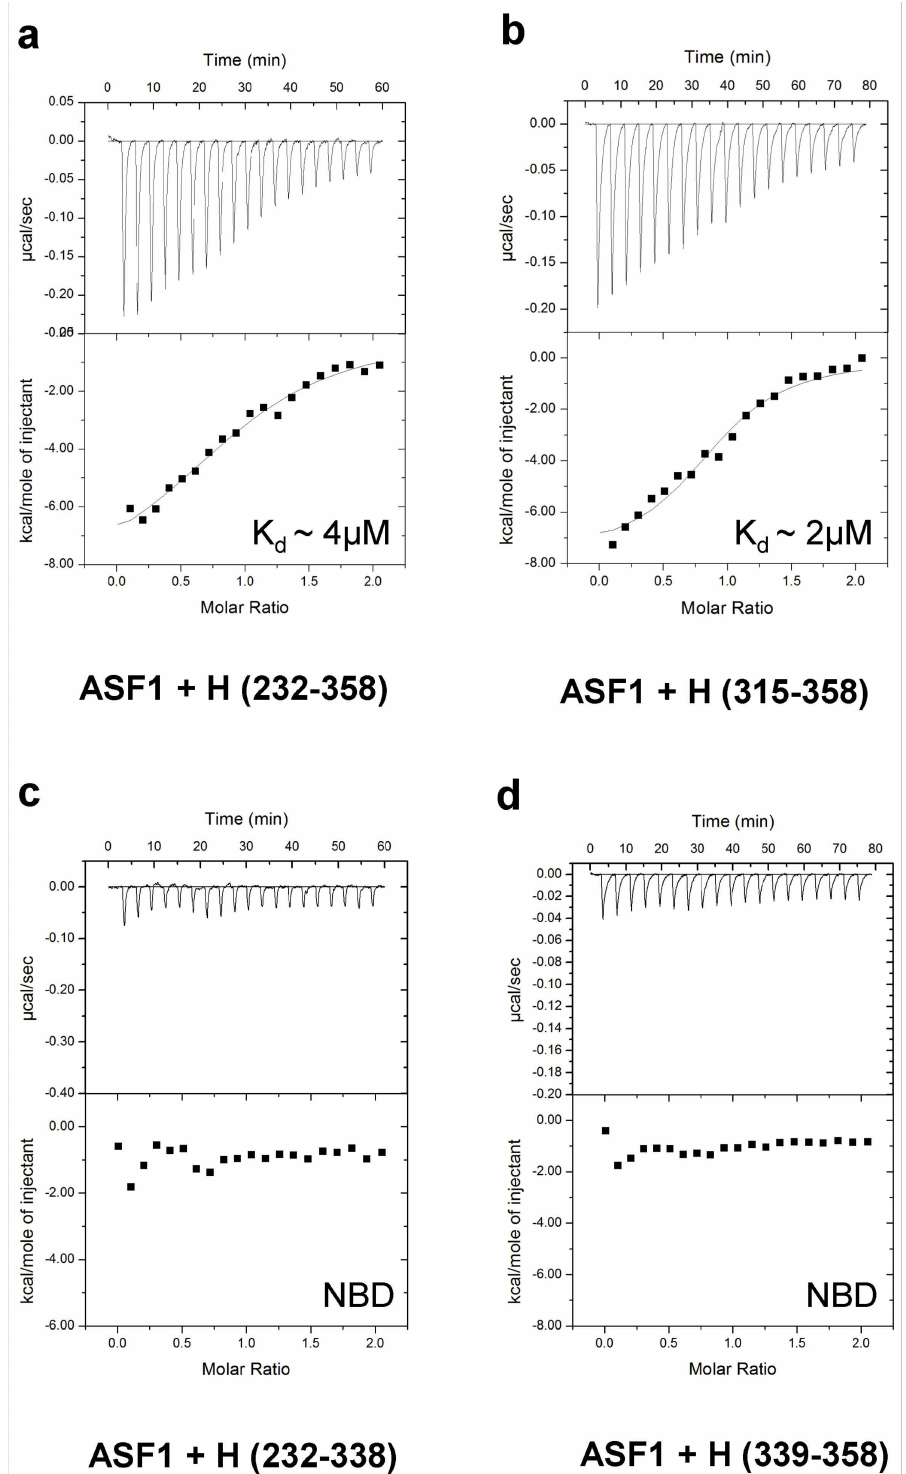
Figure 7. Mapping the Asf1–H interaction by isothermal titration calorimetry ITC. ITC binding analysis of H–Asf1 complexes. Representative thermograms showing the raw heat signal and non-linear least-squares fit to the integrated data for binding reactions of Drosophila Hairless and Asf1. Each ITC experiment was performed at 25 ◦ C with 20 injections, and the average dissociation constants (K D ) are shown. ( a ) Asf1 (1–154) binds to H (232–358) with ~4 µ M affinity. ( b ) Asf1 (1–154) binds to H (315–358) with ~2 µ M affinity. ( c , d ) No binding was detected between Asf1 (1–154) and H (232–338) and H (339–358), respectively. NBD = No Binding